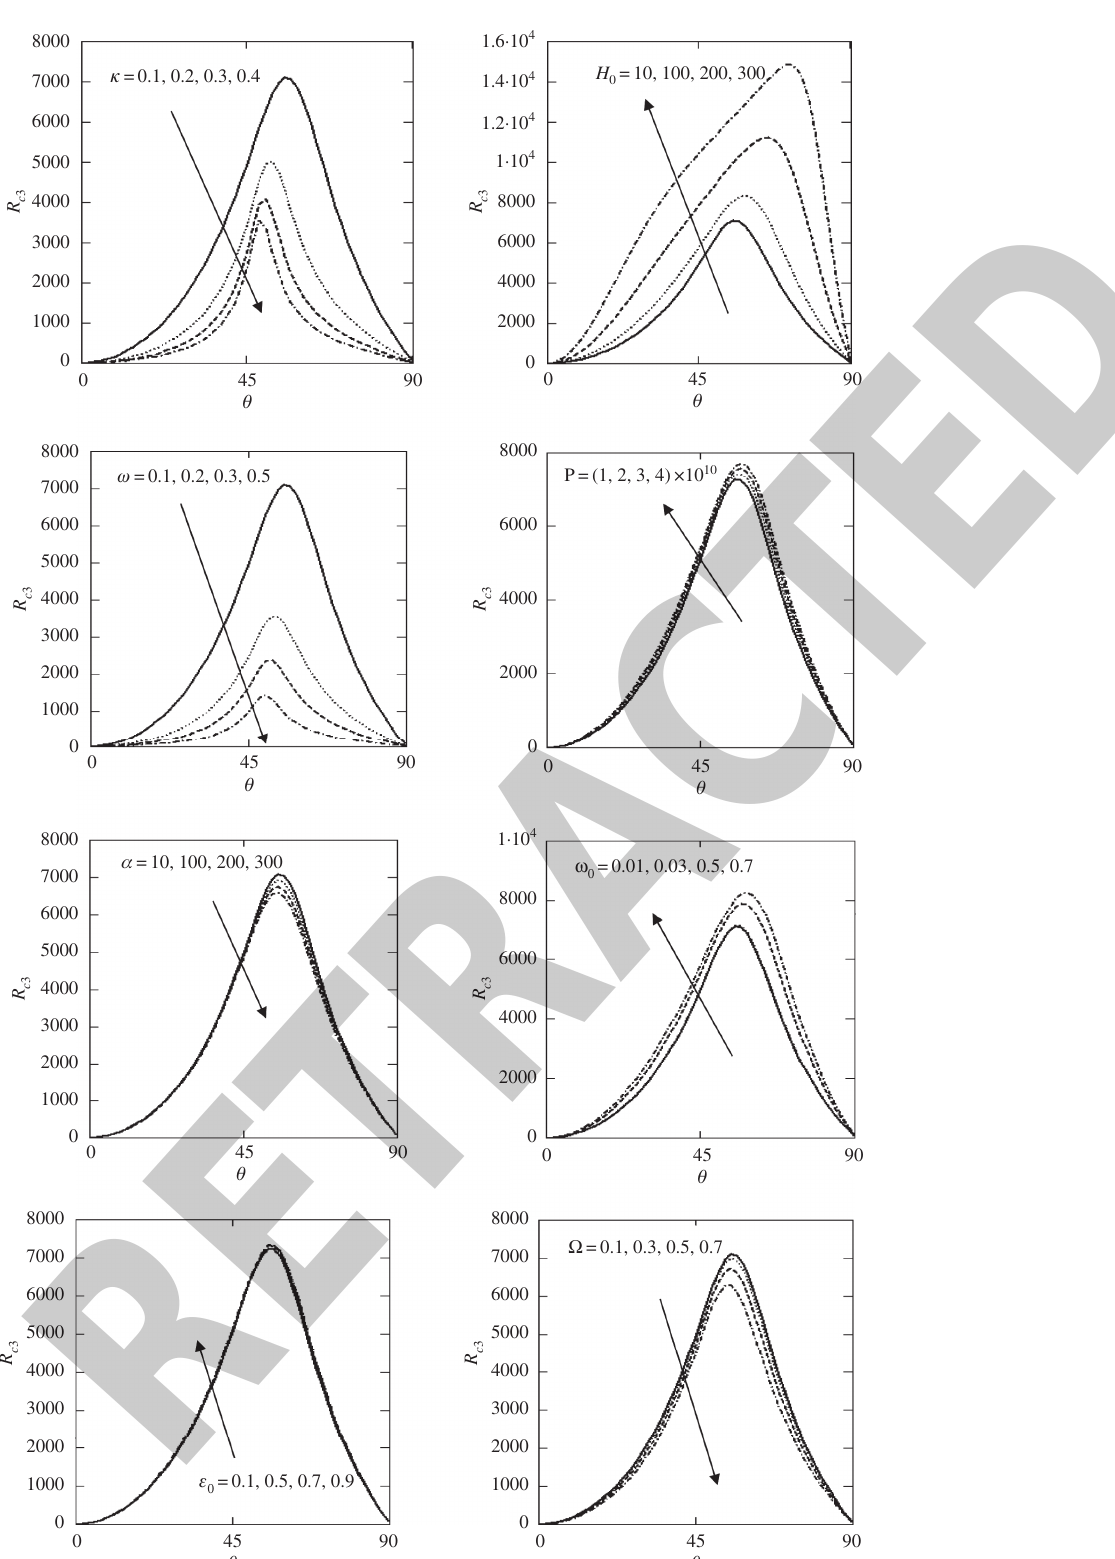
, ω , P , α , ω , ε , and Ω with respect to angle of 0 0 0